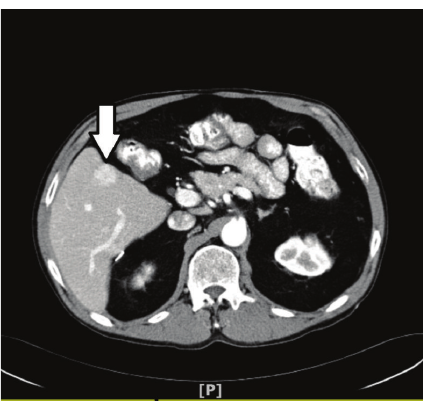
Figure 1: Arterial phase showing 2.2 × 1.6 × 2.1 lesion in segment V.